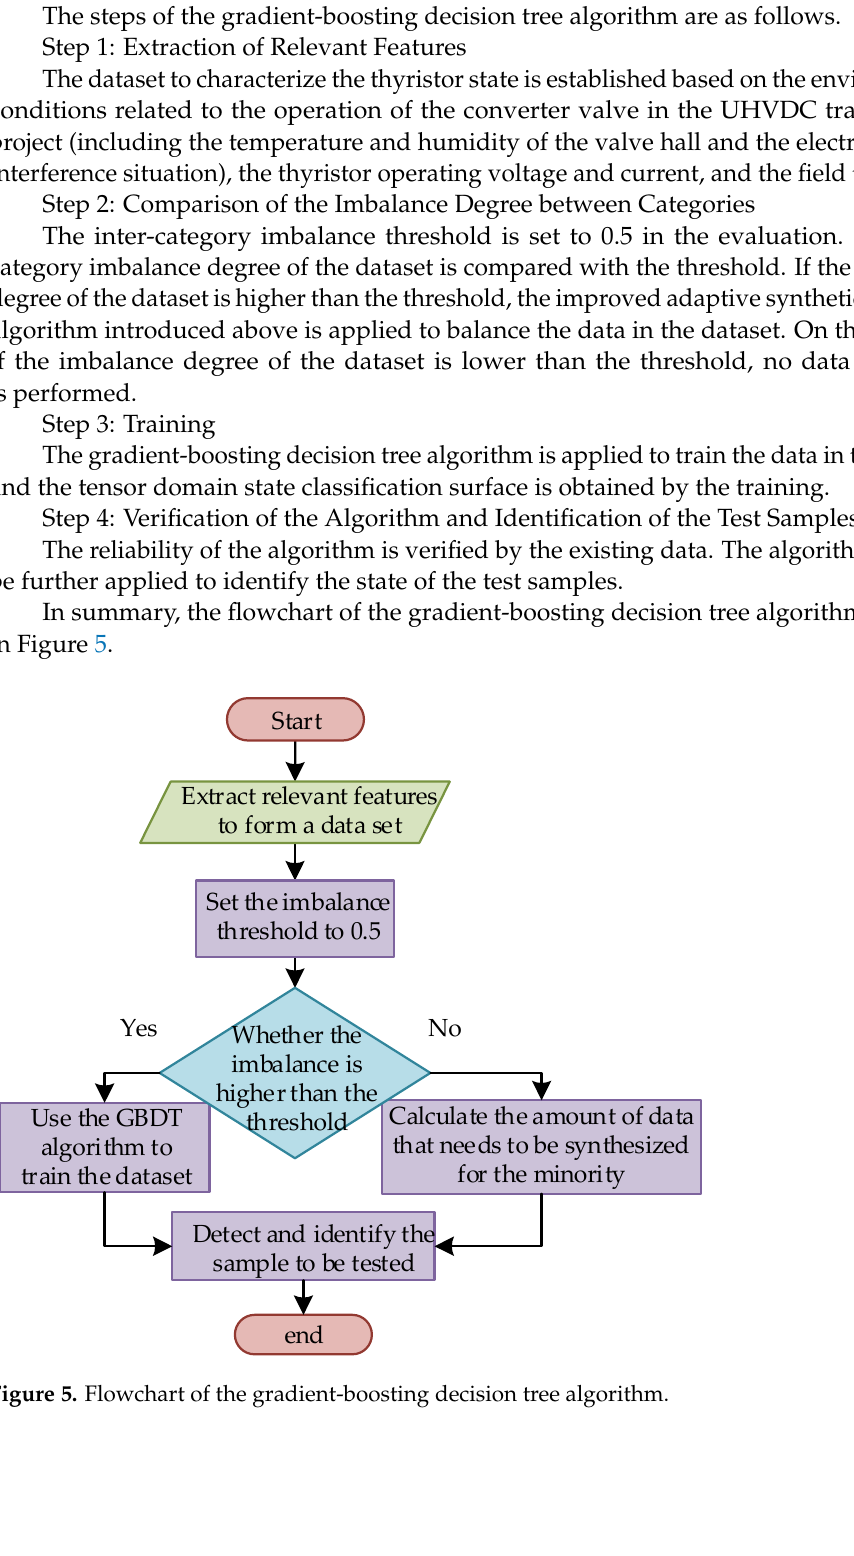
algorithm. The algorithm applies the negative gradient of the loss function corresponding to each round of the weak classifier to fit the decision tree. The negative gradient direction